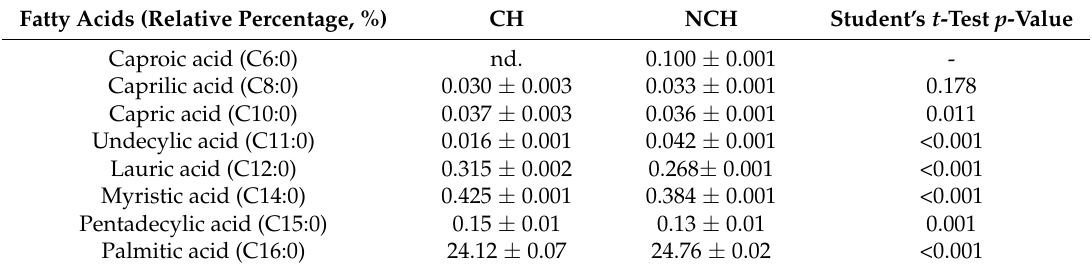
Table 2. Fatty acids composition of Cytinus hypocistis subsp. macranthus Wettst. (L.) L. using CH and NCH (Mean ±